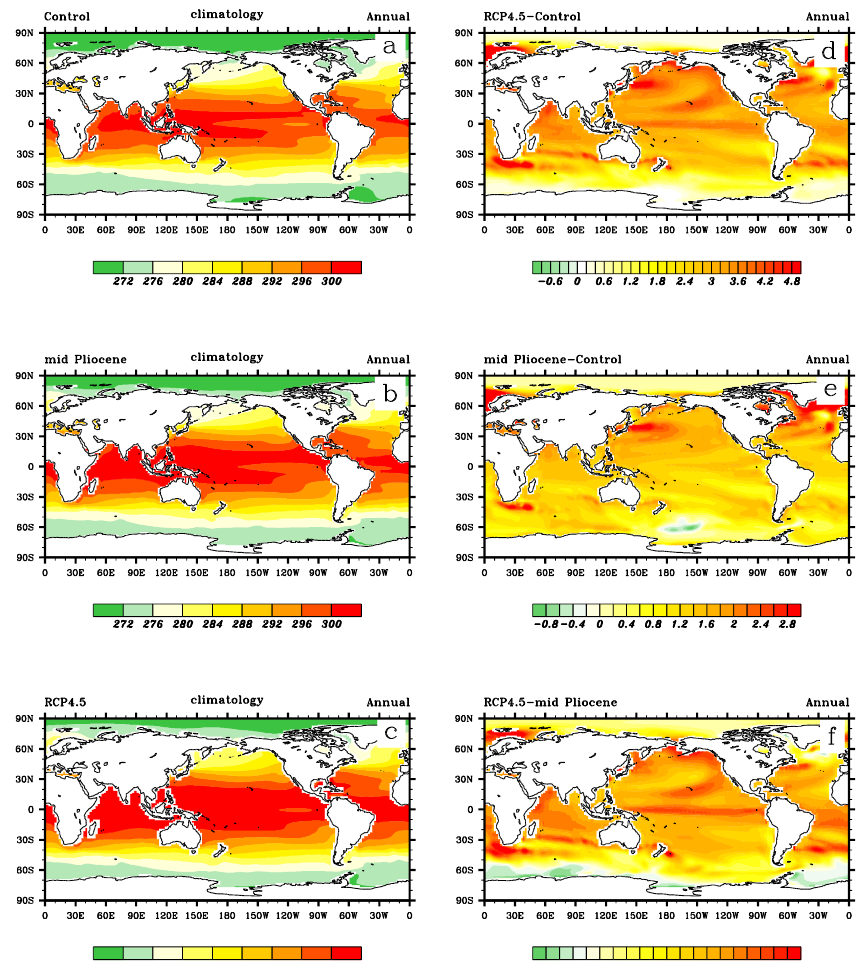
Fig. 5. Annual mean sea surface temperature (units: ◦ C) in (a) pre-industrial control run, (b) mid-Pliocene and (c) RCP4.5. Annual mean sea surface temperature anomalies (d) between RCP4.5 and control run, (e) between mid-Pliocene and control run, and (f) between RCP4.5 and mid-Pliocene.